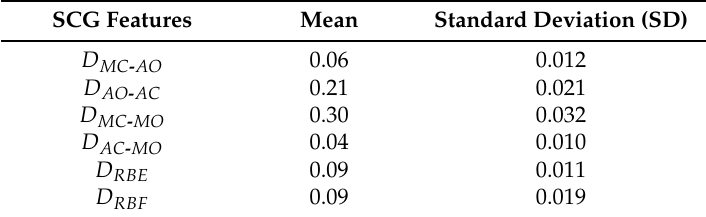
Table 7. Sample value of SCG features.